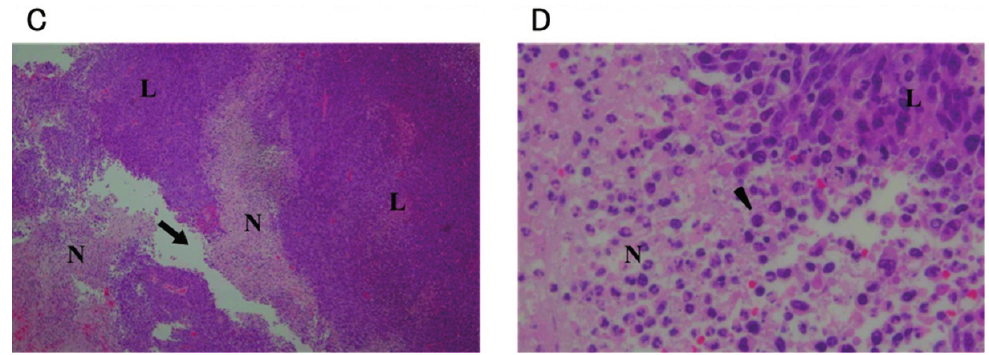
Figure 5. Histological images of tumors that were either untreated or administered sterile distilled water, after 24 h. Non-treated ( A , B ); treated with sterile distilled water ( C , D ). Low magnification (40×): ( A , C ); High magnification (400×): ( B , D ). All sections were stained with hematoxylin and eosin. N: necrotic area; L: viable tumor area; arrow: site of injection; arrowhead: pyknotic nuclei.